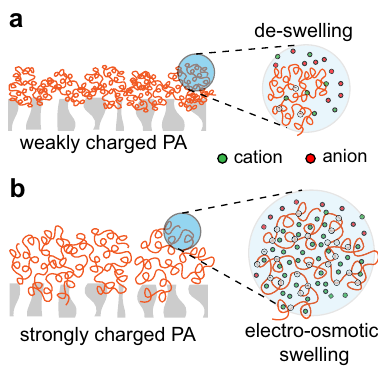
Fig.1|Theoryofelectricallyinducedosmoticporesizeregulation.a De-swelling